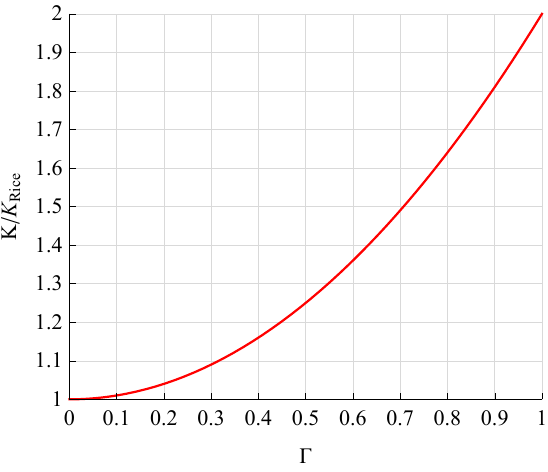
Figure 3. Dependence of K / K Rice on Γ . Consequently, in most TWDP literature, PDF and ASEP curves are plotted only for specific values of ∆ , i.e., ∆ = 0.5 and ∆ = 1, for which the mentioned differences can